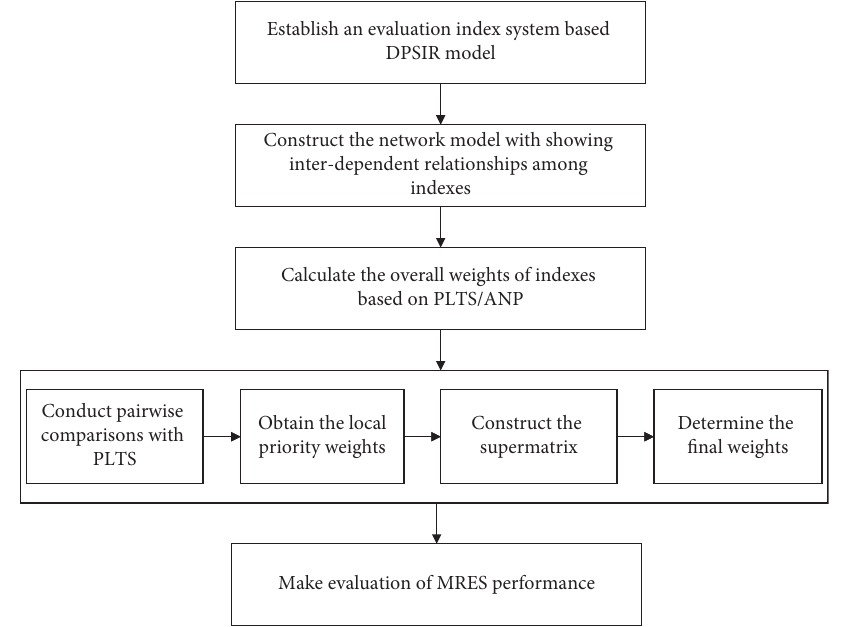
Figure 1: Framework of MRES